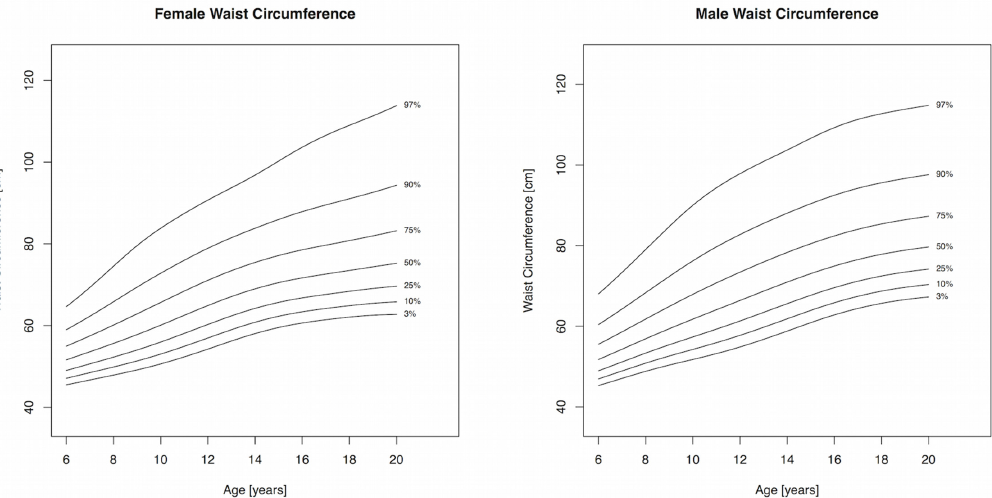
Fig 2. Percentile curves for waist circumference for male and female Canadian children and youth aged 6 to 19 years.